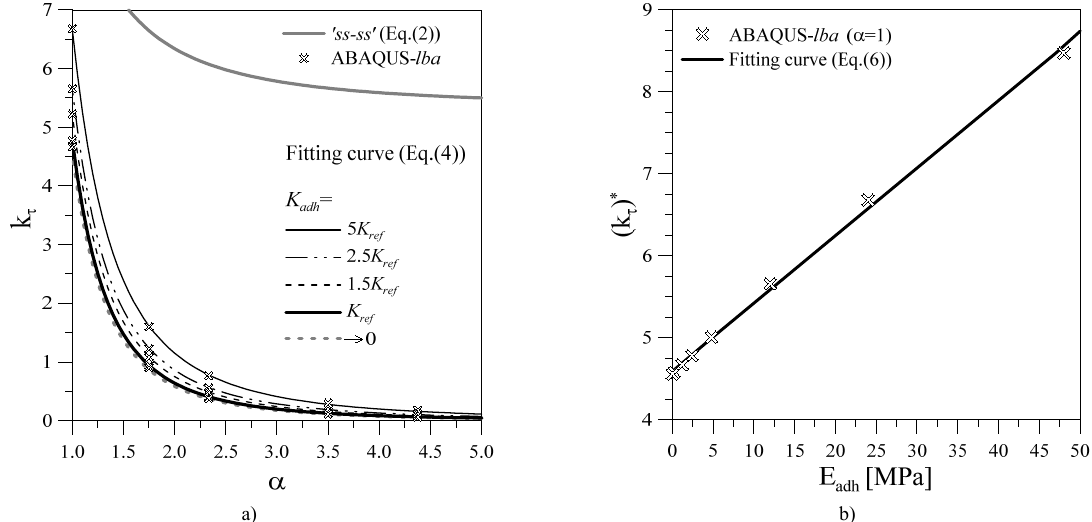
Fig. 4 FE numerically derived and analytical fitting curves for linear adhesively restrained glass shear walls. a) k  buckling coefficients and b) FE-analytical